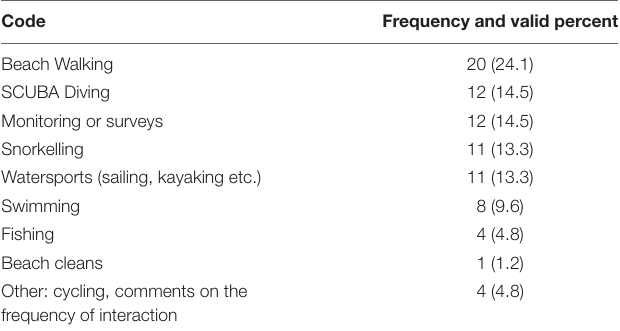
TABLE 3 | Respondent’s primary methods of interaction with the marine environment.